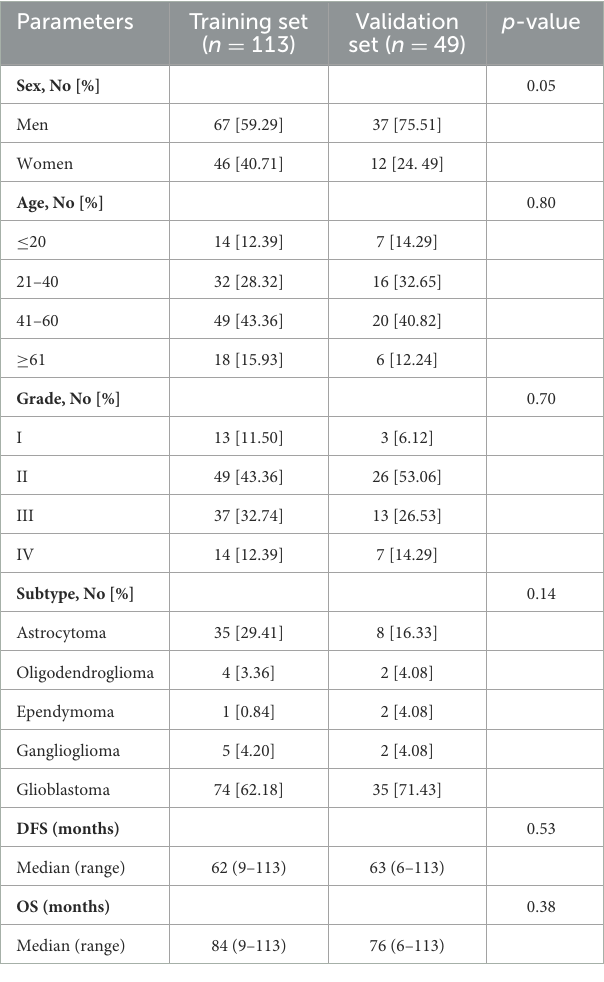
TABLE 1 The clinicopathological features of 162 patients with glioma.